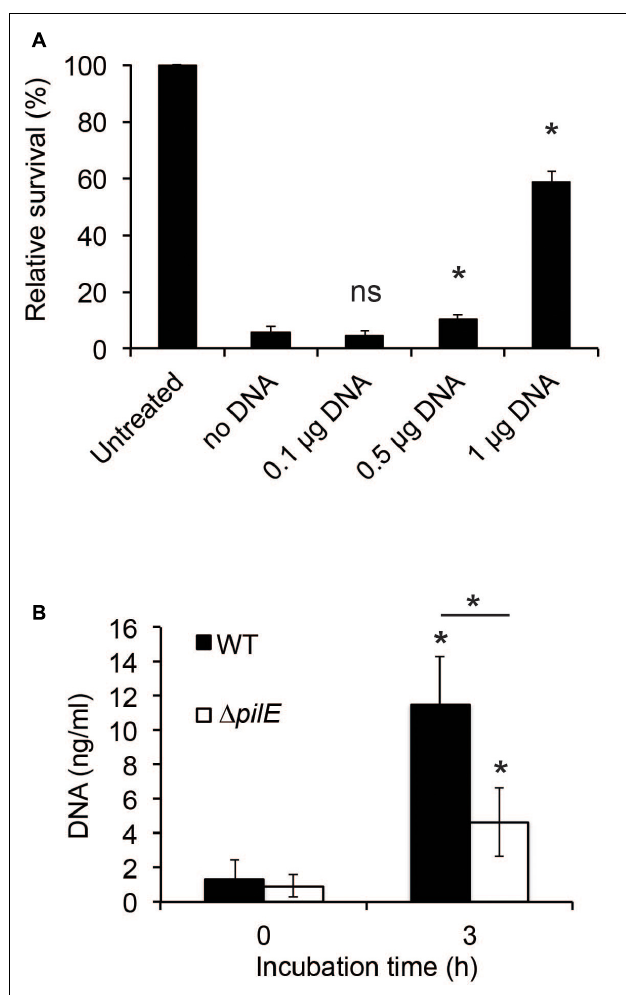
FIGURE 6 | The presence of DNA reduces hBD2 antibacterial activity. (A) N. meningitidis DNA (0.1, 0.5, or 1 µ g) was incubated with 5 µ M hBD2 for 15 min, subsequently added to log-phase bacteria and incubated for 3 h. Viable counts were determined by plating. Values are expressed as the mean survival relative to the untreated control. Significance was tested against the sample without DNA. The assay was performed in triplicate at least three times. (B) Log-phase WT and (cid:49) pilE cells were incubated untreated for 3 h. Detection of eDNA in the supernatants was determined by a fluorescence-based Quant-iT PicoGreen DNA assay kit. Significance was tested against the 0 h time-point and as indicated. The assay was performed in triplicate at least three times. Data are represented as the mean values, with error bars representing the standard deviation. * P < 0.05; ns,